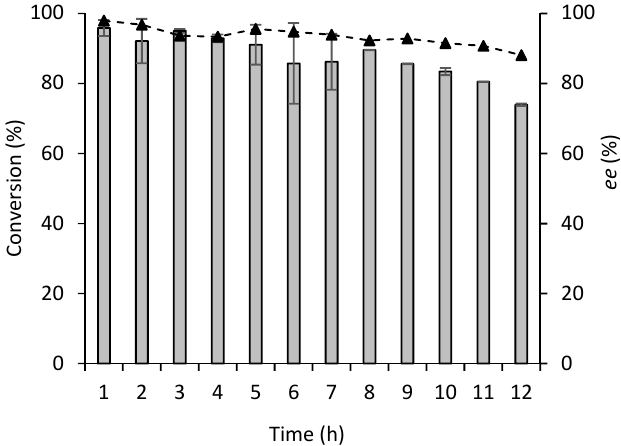
Figure 5. Stability of wet At HNL-EziG Opal (10 U mg − 1 ) in continuous flow at 0.1 mL min − 1 . Immobilization was performed by adsorption. Conversion (bars), enantiomeric excess (dotted line and triangles). Conditions: benzaldehyde (0.5 M), HCN solution in citrate / phosphate bu ff ered MTBE (1.5–2 M) pH 5, 1,3,5-triisopropylbenzene (50 mM, I.S.), a CFR with At HNL immobilized on 150 mg EziG Opal. Mol ratio of monomeric At HNL:Fe 3 + was 1:4. Reactions were performed at room temperature. Error bars correspond to the standard deviation of duplicates ( n = 2) during the first 7 h. From hour 8, error bars correspond to the standard deviation of duplicates ( n = 2) HPLC samples of the single experiment.